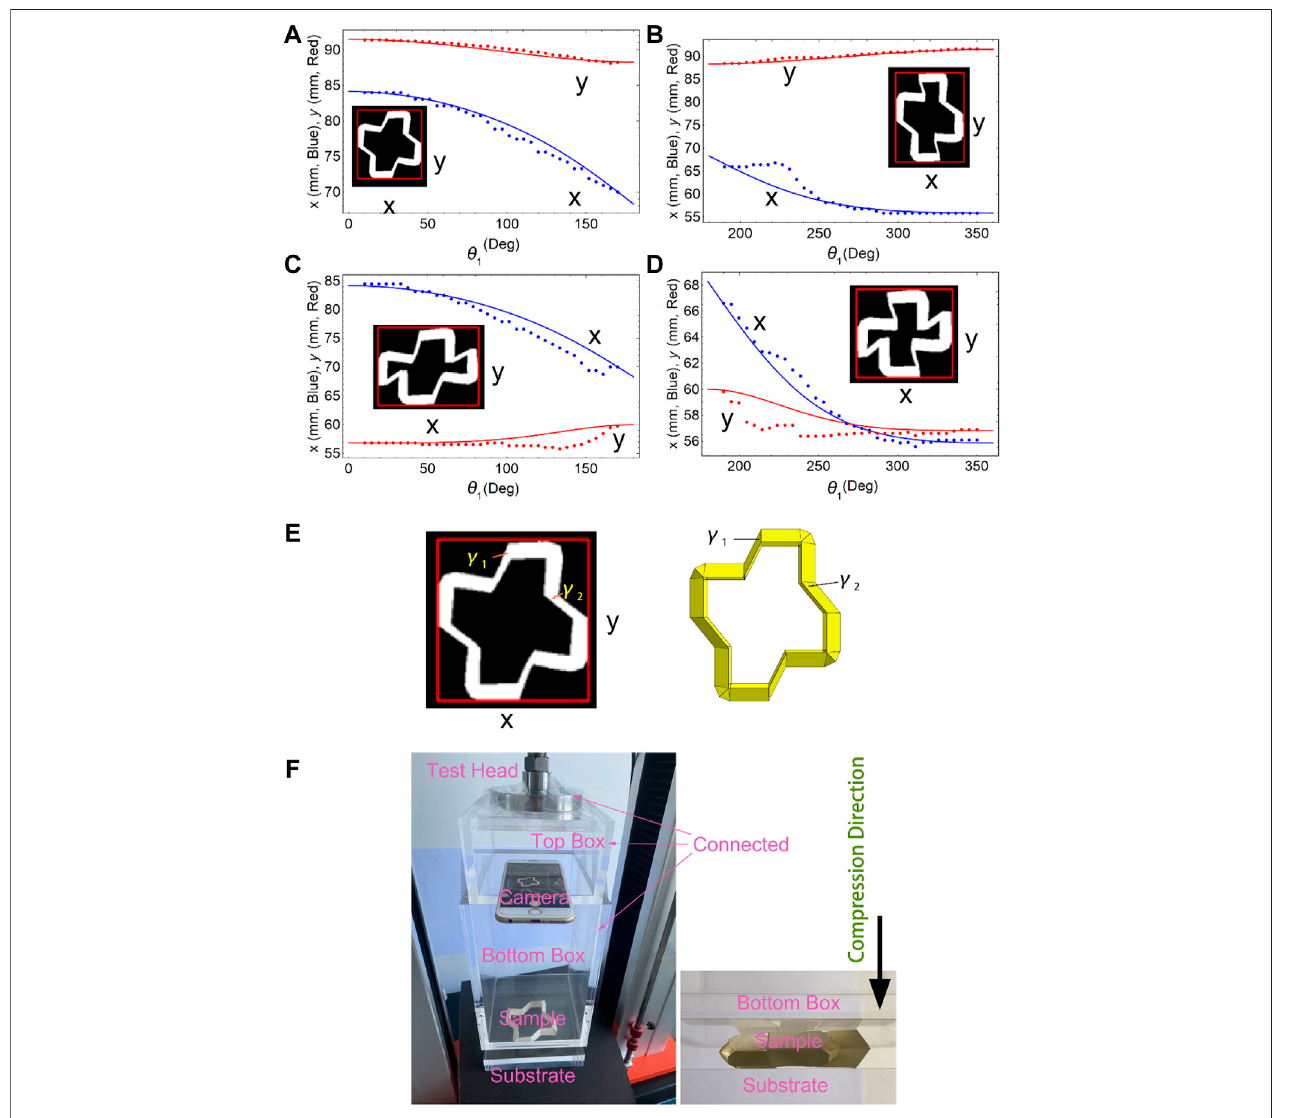
FIGURE3| Experimentalveri fi cation.Dimensionsofaunitwith γ 1 (cid:1) 45 ° , γ 2 (cid:1) 60 ° ,and β (cid:1) 90 ° undercompressioninthe z -directionforfourpatterns: (A) ① , (B) ③ , (C) ④ , and (D) ⑥ (curves, analytical model; points, measured data). (E) γ 1 and γ 2 in the binary image and structural model. (F) Experimental setup.